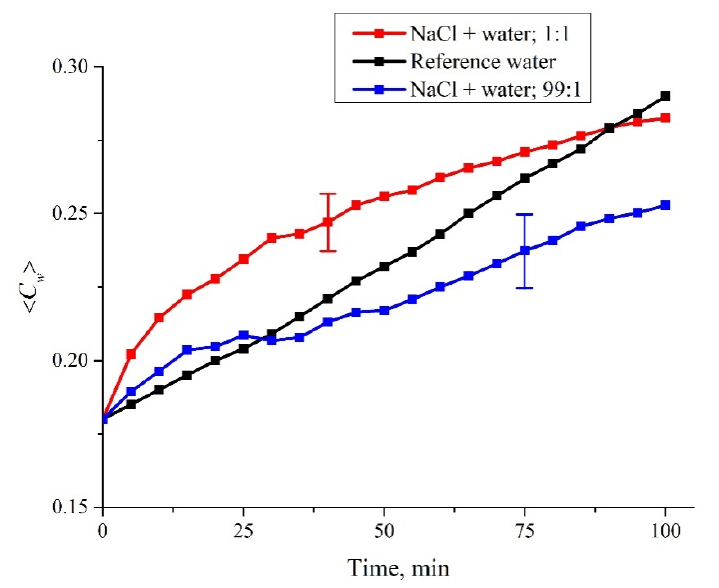
Figure 9. Dependence of the average concentration C w ( t ) for NaCl (1 M) solutions prepared by dilution with water according to the first (1:1) and second (99:1) protocols. The dependence C w ( t ) for deionized (reference) water is also shown.